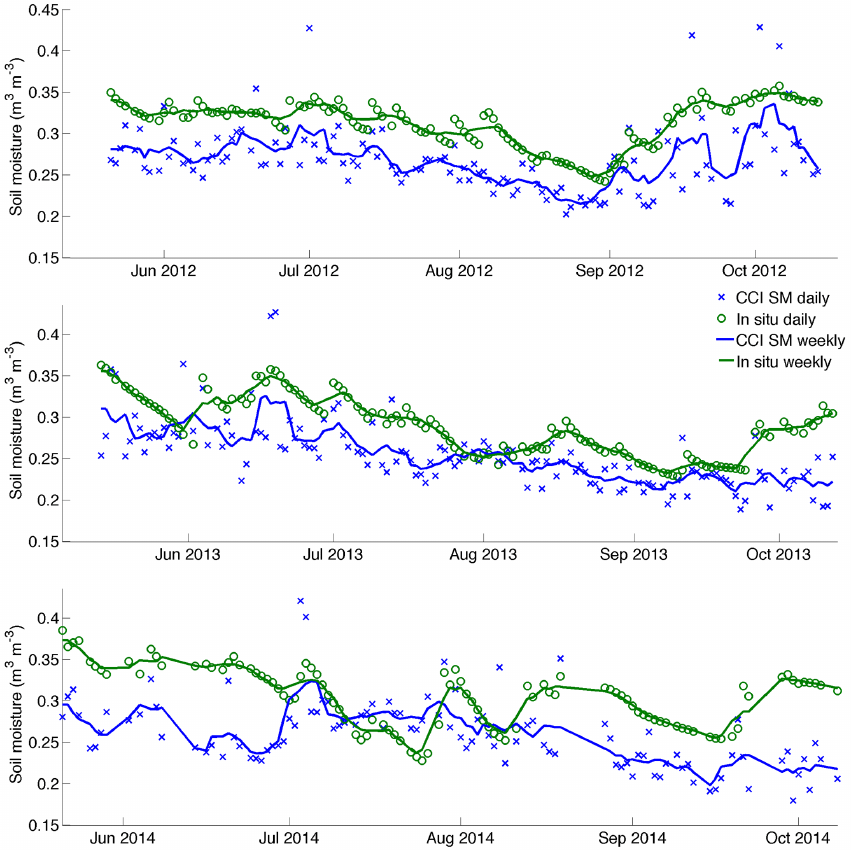
Figure 8. Time series of daily and weekly averaged top soil layer ESA CCI soil moisture data product estimates in comparison against daily and weekly averaged spatially weighted areal average in situ observations for the years 2012, 2013, and 2014.